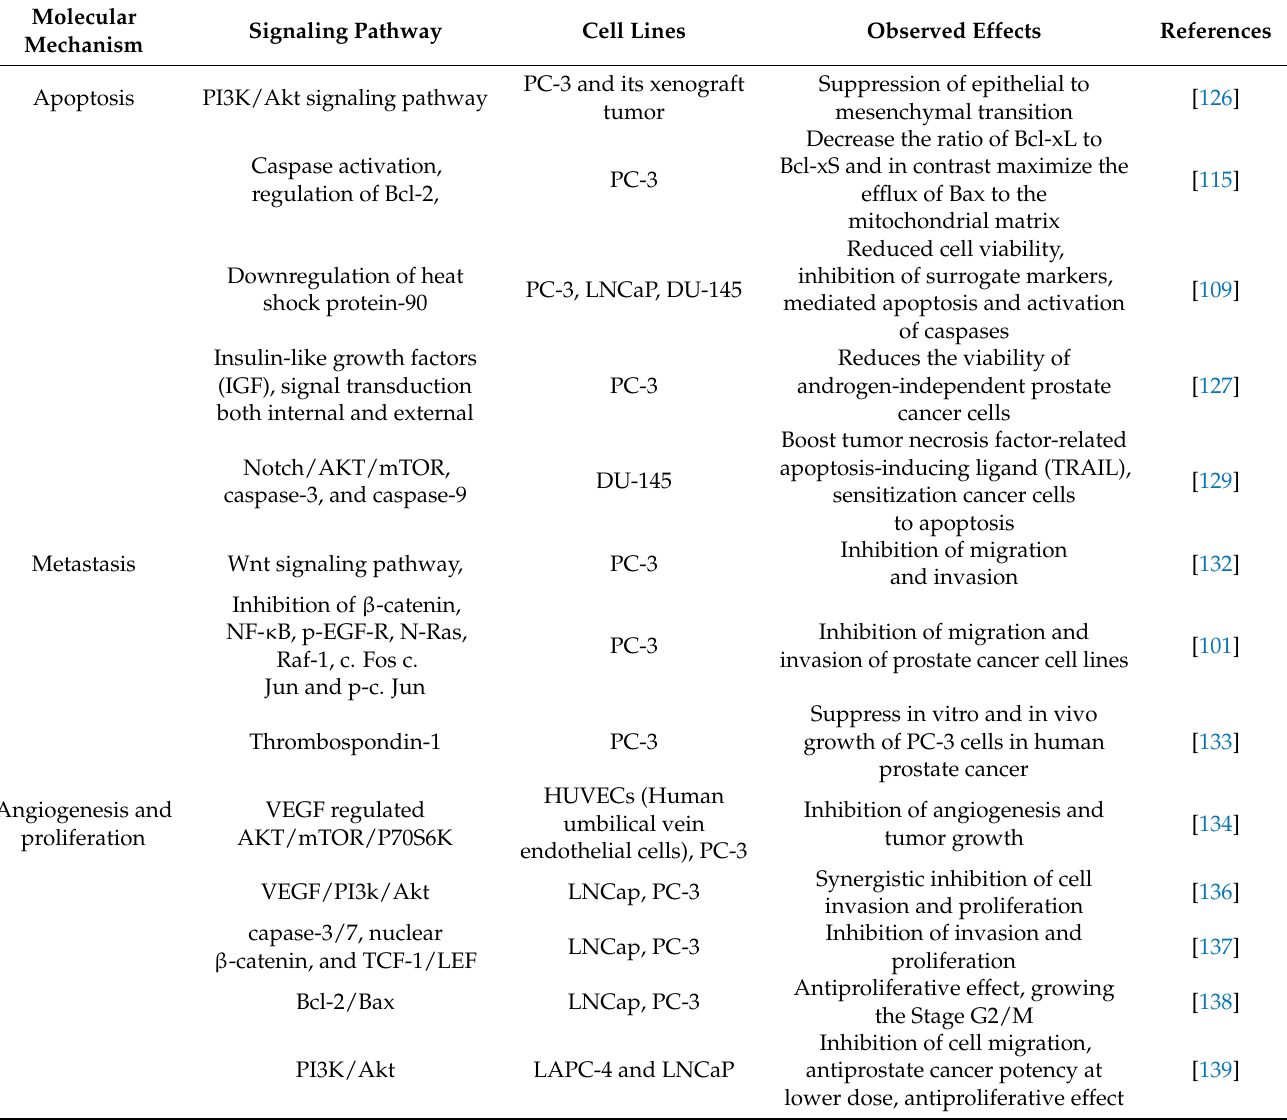
Table 2. Comparative details of quercetin on multiple cell lines of prostate